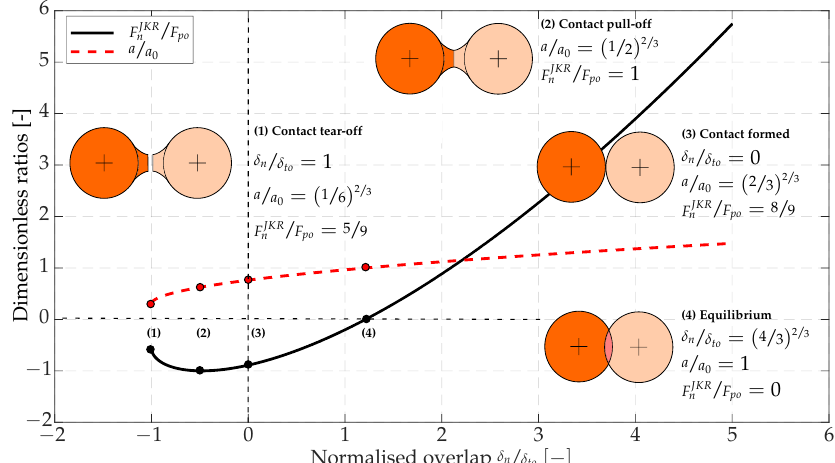
Figure 4. Schematic example of the JKR model